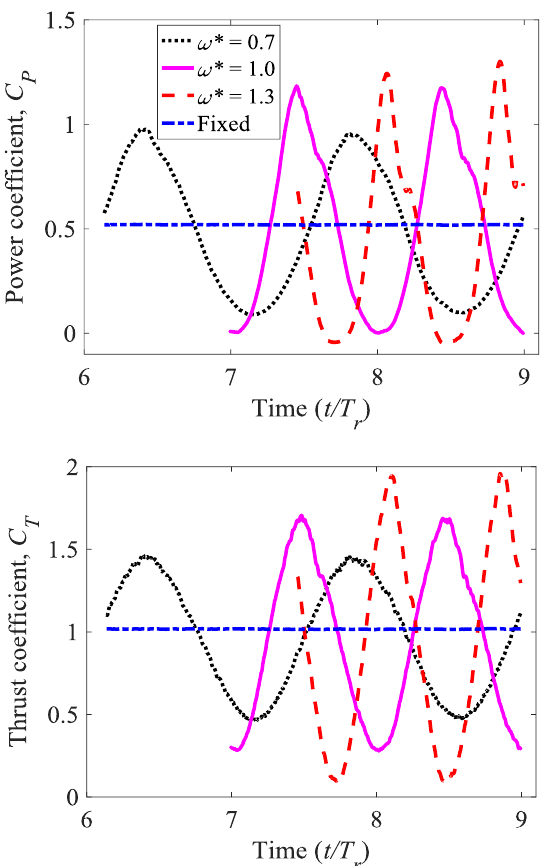
Fig. 18. Time histories of power and thrust coefficient for fixed and surging turbine oscillating at 𝜔 ∗ = 0.7, 1.0, and 1.3. The 𝐴 ∗ = 0.1 and 𝜆 = 4.4 were kept constant.